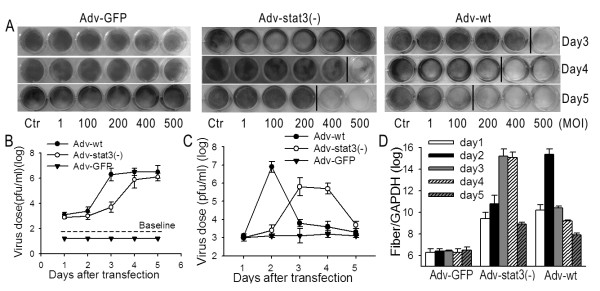
Adv-Stat3(-) replicates adequately in MSCs and is eventually released. (A) Cytopathic effects of Adv-GFP, Adv-Stat3(-), and Adv-wt on MSCs. MSCs were infected with Adv-GFP, Adv-Stat3(-), and Adv-wt at different MOI. The cytotoxic activity was evaluated by crystal violet staining at each time point. The control without any viral infection is indicated as Ctr. (B) Viral count in the culture medium of MSCs was expressed as mean ± SD in three independent experiments. MSCs were infected with 500 MOI Adv-GFP, Adv-Stat3(-), and Adv-wt. At each time point, the culture medium was collected and the viral concentration measured using the TCID50 method. (C) Intracellular viral concentration was expressed as mean ± SD in three independent experiments. MSCs were infected with 500 MOI Adv-GFP, Adv-Stat3(-), and Adv-wt. At each time point, the intracellular virus was extracted by three cycles of freezing and thawing and measured using the TCID50 method. (D) DNA replication of Adv-GFP, Adv-Stat3(-), and Adv-wt in MSCs. MSCs were infected with 500 MOI Adv-GFP, Adv-Stat3(-), and Adv-wt. At each time point, MSCs were harvested and real-time PCR performed to measure the amount of viral DNA. Results are the means of three independent experiments and expressed as the ratio with GAPDH. Negative controls omitted templates.